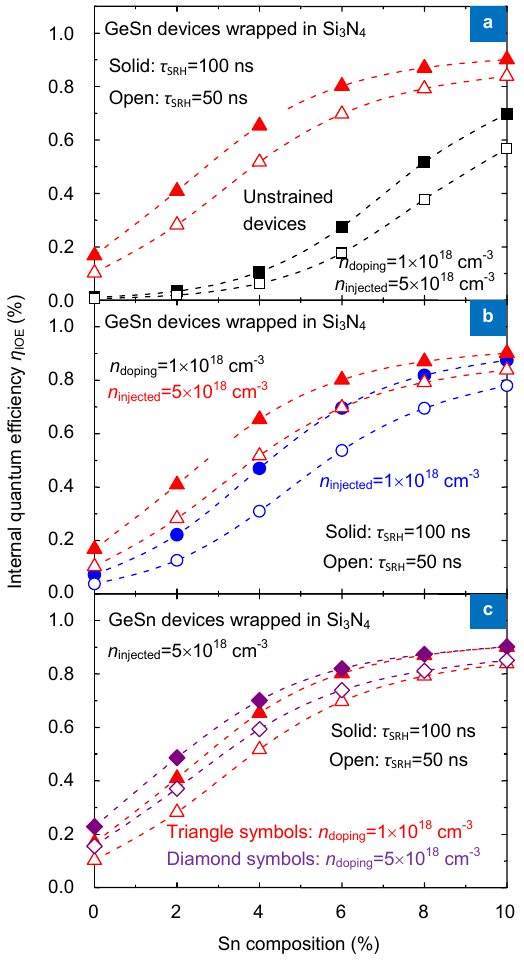
Fig. 13 | η IQE versus Sn composition characteristics of lattice-matched GeSn/SiGeSn DH LEDs with the τ SRH of 100 and 50 ns . ( a ) Relaxed and tensile strained GeSn devices. ( b ) Strained GeSn devices wrapped in a Si 3 N 4 liner stressor with different values of n injected . ( c ) Strained devices with different n doping . Figure reproduced from ref. 37 , Optical Society of America.